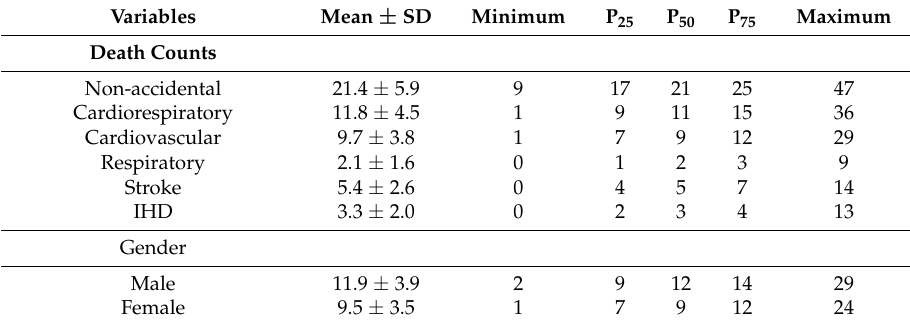
Table 2. Descriptive statistics of daily mortality and YLL due to non-accidental deaths, stratified by causes, gender, age, and education level, in Wuhan, China,